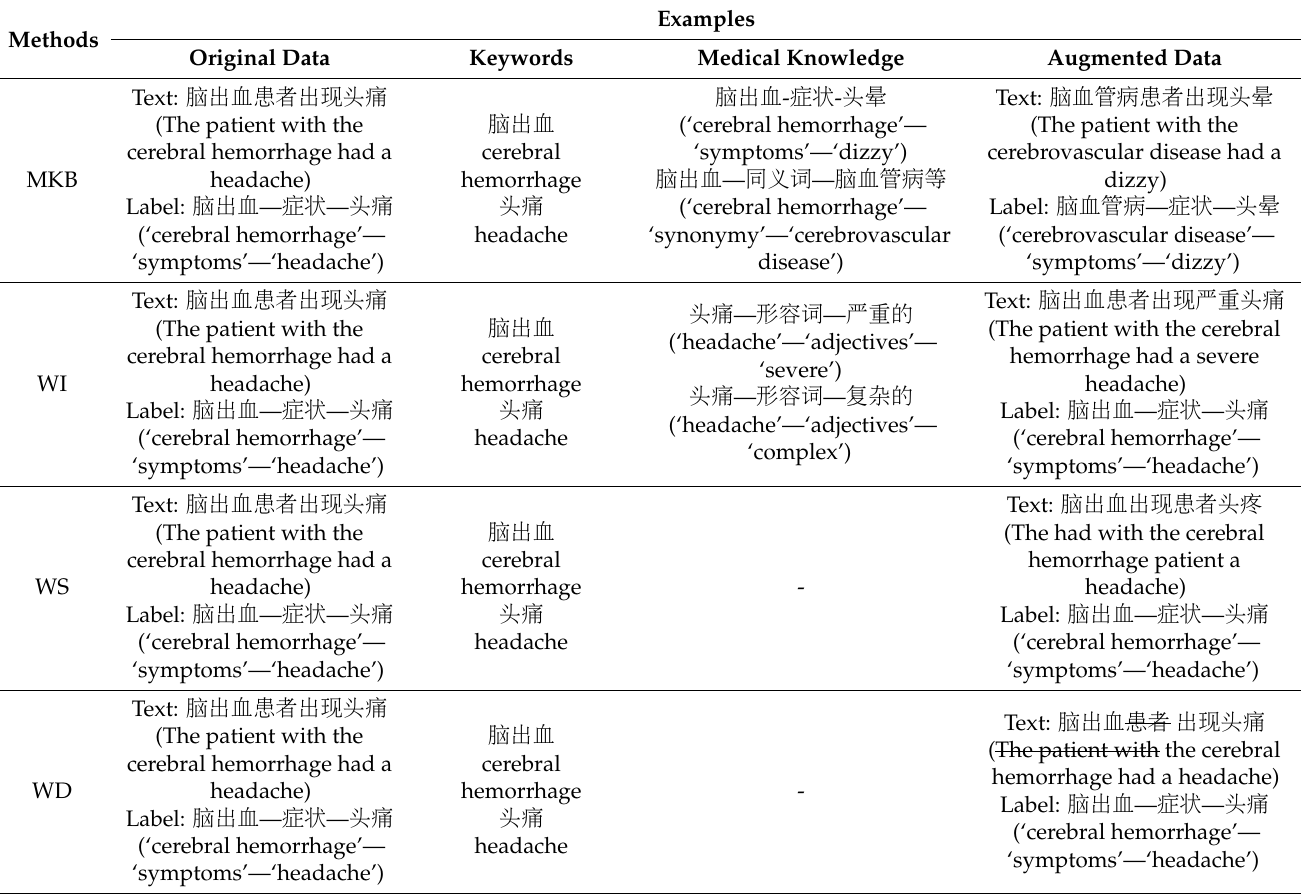
Table 2. The MDA of four text data augmentation